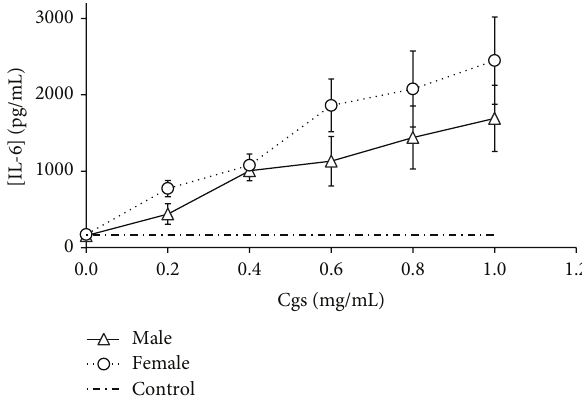
Figure 4: Increase in IL-8 concentration (pg/mL) in culture med- ium after the 24-hour incubation of PBMCs from male and female healthy subjects with Cgs isolated from the blood of male and female SCZ patients, respectively.